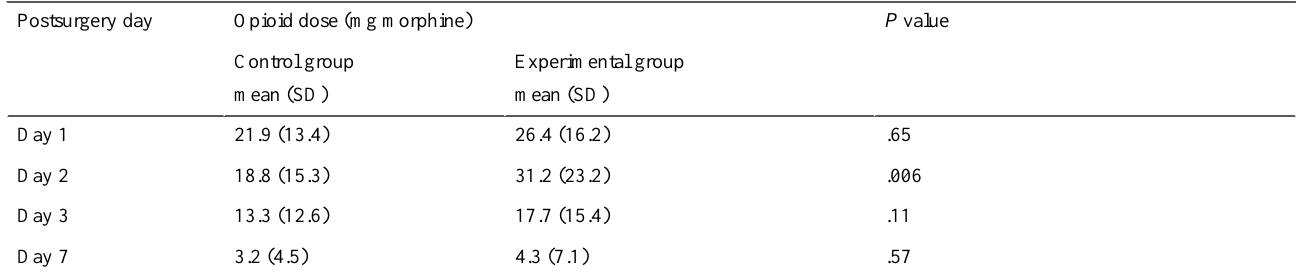
Table 6. Opioid dose after surgery expressed into milligrams (mg) of morphine equivalents for both control and experimental groups.